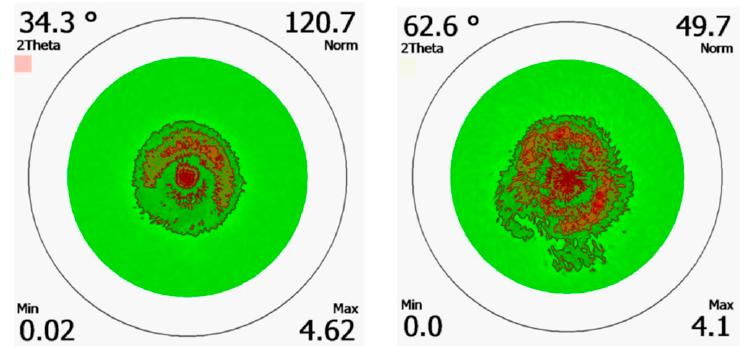
Figure 9. Pole figures for (002) and (103) Si/AlN/GaN stacked thin film structure. Figure 10 presents the PL spectra of Si/GaN and Si/AlN/GaN thin-film structures obtained with a He–Cd laser at a wavelength of 325 nm, excitation power of 30 mW, and measurement temperature of 10 K. In the measurement, a 0.5-meter monochromator (iHR 550) was used to measure the signal using a cooled charge-coupled device. PL spectroscopy was used to investigate the energy bands, impurities, energy transitions, crystal quality, and defect types of the GaN samples. The near-band-edge emission (NBE; 365 nm) of the GaN thin films deposited through sputtering was investigated; the near-band- edge emission is critical for developing high-quality GaN films for different